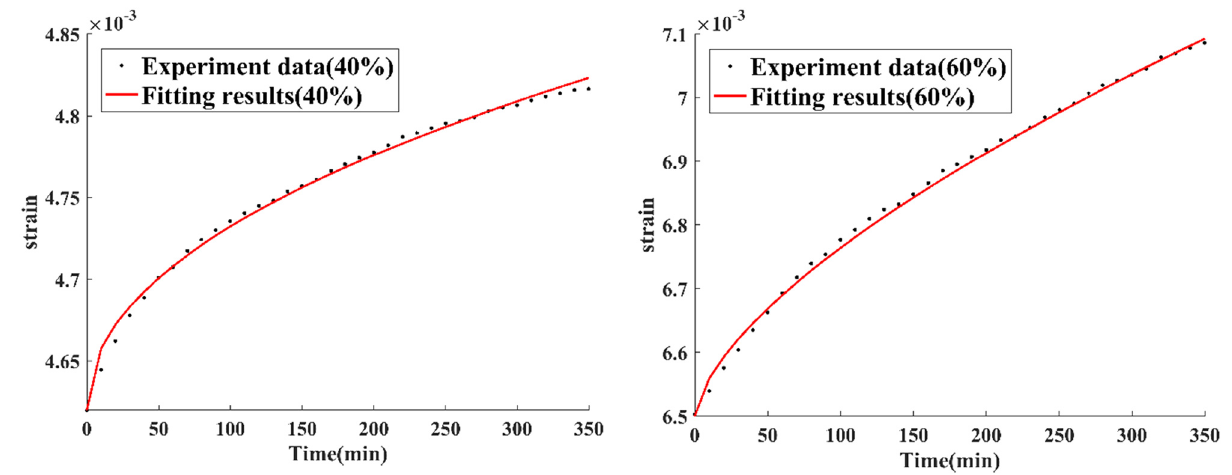
Figure 17: Fitting results based on the fractional de fi ned Maxwell model and 60% stress level.